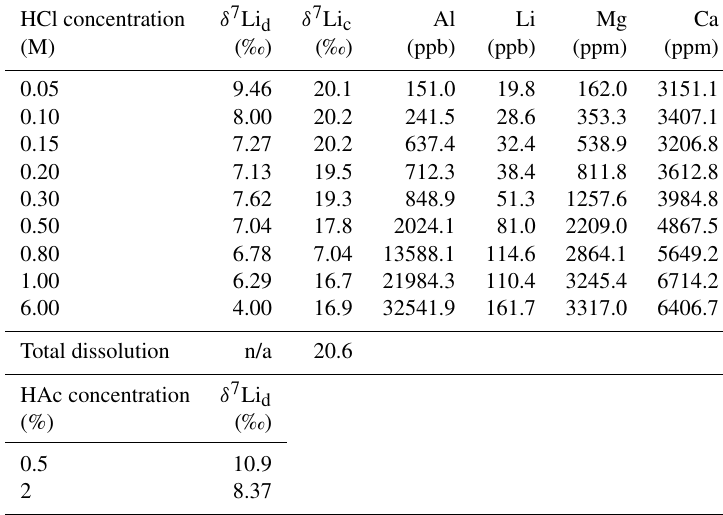
Table 3. Lithium isotope compositions and elemental concentrations of solutions from the dolostone and coral leaching experiments with HCl and